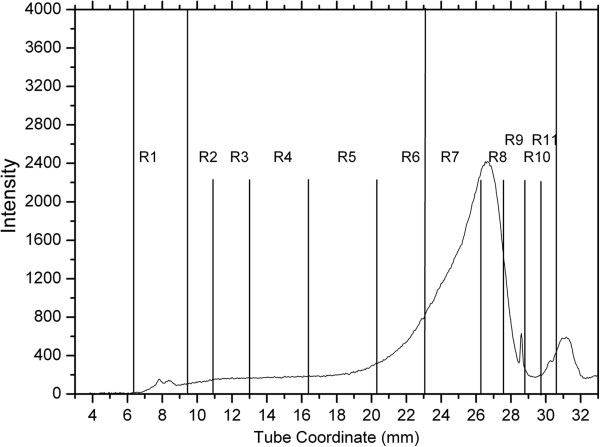
Representative continuous lipoprotein density profile from a dog of group 1 (normolipemic dogs of breeds other than Miniature Schnauzers). Intensity refers to the number of pixels of fluorescence emission recorded. The x-axis provides the distance in mm from the top of the 33 mm ultracentrifuge tube. This dog had serum TAG and cholesterol concentrations within the respective reference intervals. The most abundant lipoprotein fractions are R7 and R8 (which correspond to a density for HDL), seen at a tube coordinate between 23 mm and 31 mm. R2 to R6 fractions (corresponding to LDL densities) are present in very small amounts and are seen at a tube coordinate between 9 mm and 23 mm. The R1 fraction (that corresponds to TRL densities) appears at tube coordinates of 6 mm to 9 mm in very small amounts.